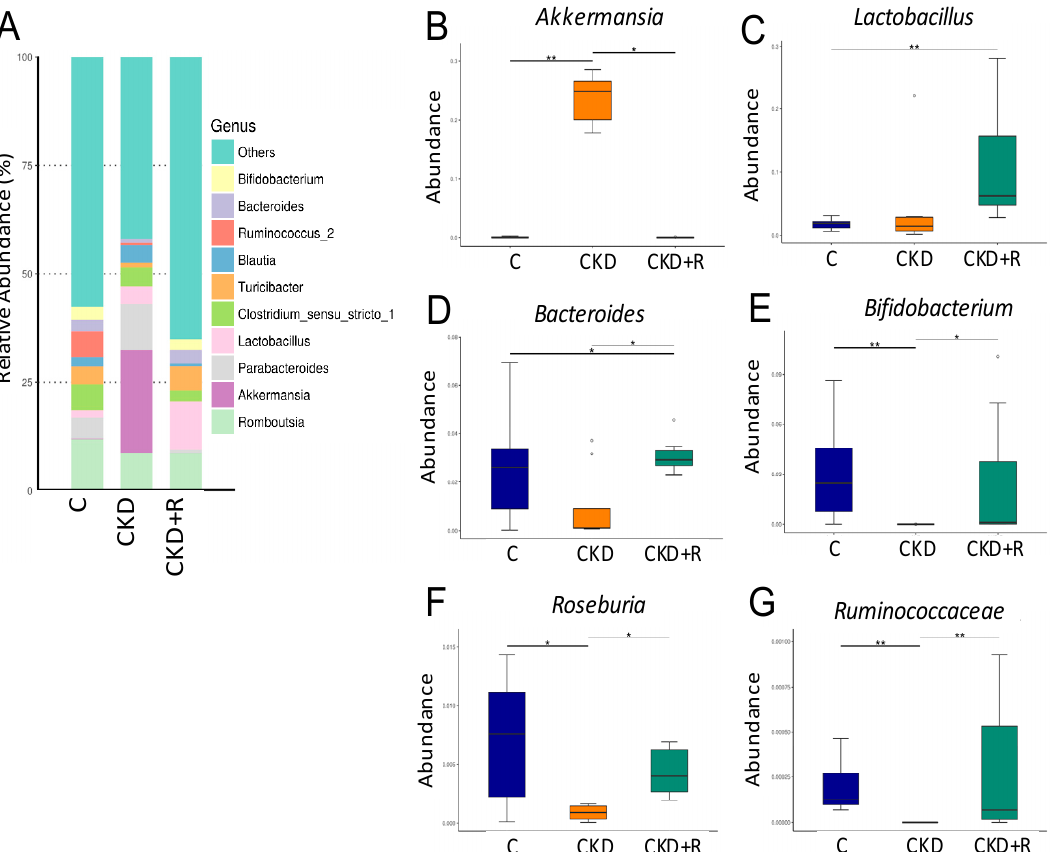
Figure 4. Effects of maternal CKD and R treatment on the gut microbiota in 12-week-old male offspring. (A) Relative abundance of the top 10 genera in the three groups. Abundance of the genera (B) Akkermansia , (C) Lactobacillus , (D) Bacteroides , (E) Bifidobacterium , (F) Roseburia , and (G) Ruminococcaceae in the three groups. * p < 0.05; ** p < 0.01.